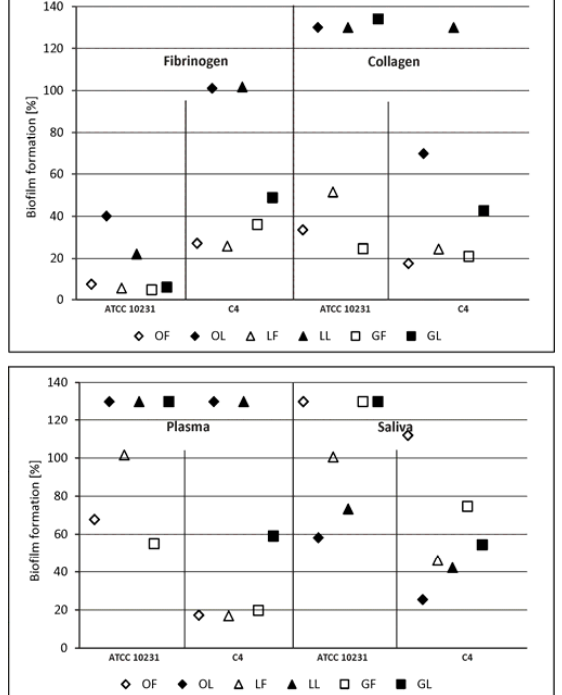
Figure 3. Candida albicans ATCC 10231 and clinical C. albicans C4 biofilm formation on surfaces conditioned with host-derived proteins/body fluids (fibrinogen, collagen, plasma, saliva) in the presence of subMICs of fractionated SBT extracts. LF, GF, OF denote phenolic fractions of leaf, twig, and fruit-derived extracts, respectively; LL, GL, OL denote nonpolar (lipid) fractions of leaf, twig, and fruit-derived extracts, respectively. Inhibitory effect was analyzed in terms of metabolic activity of biofilm mass by the “FDA reduction” method. The percentage ± S.D. of biomass activity compared with the control (untreated), which was considered as 100%, is presented.